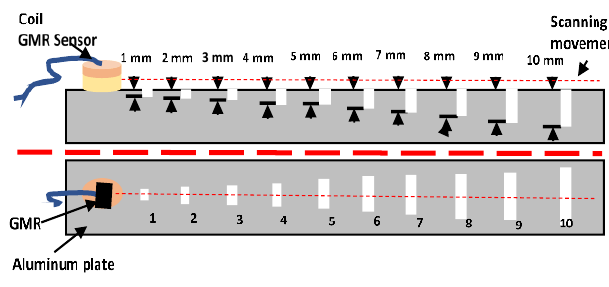
FIGURE 13 Representation of the performed scan: (a) Side view; (b) Top view.